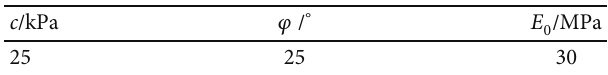
Figure 3: The fi tting relationship between s / p and s based on the results of in situ loading test 2#. Table 2: Calculated parameters of the nonlinear deformation modulus